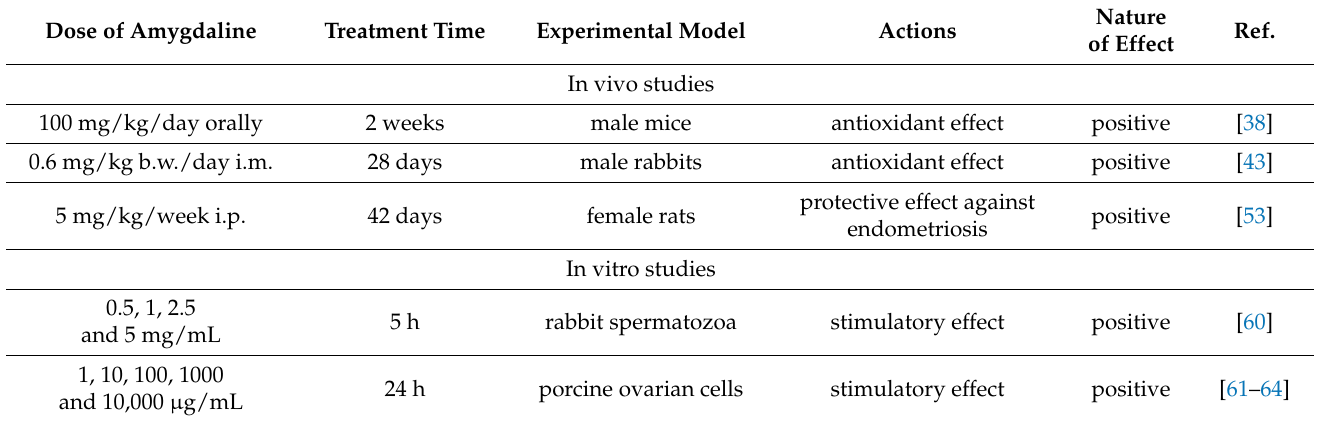
Table 2. Physiological and therapeutic actions of amygdalin on reproductive processes. Dose of Amygdaline Treatment Time Experimental